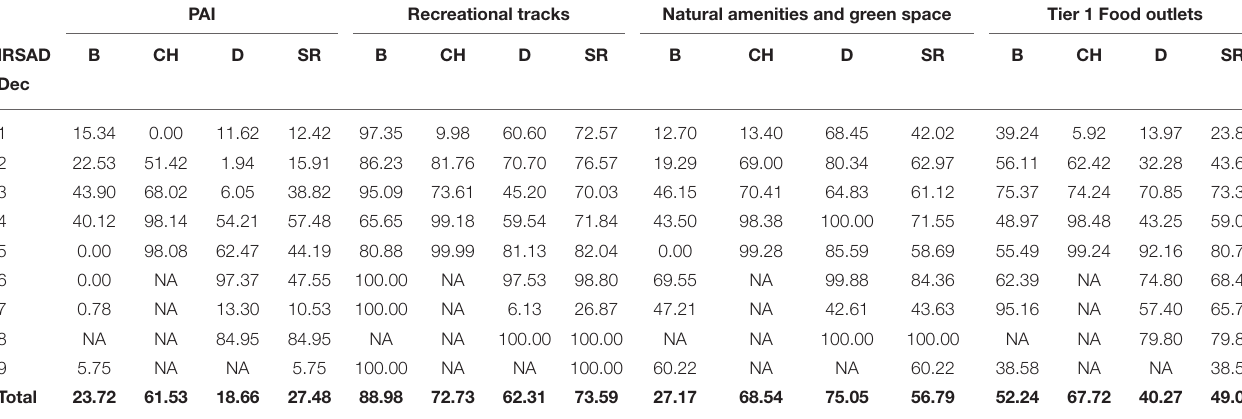
TABLE 4 | Proportion of the population in each region with poor access to PAI and food outlets based on socioeconomic disadvantage (IRSAD). PAI Recreational tracks Natural amenities and green space Tier 1 Food outlets